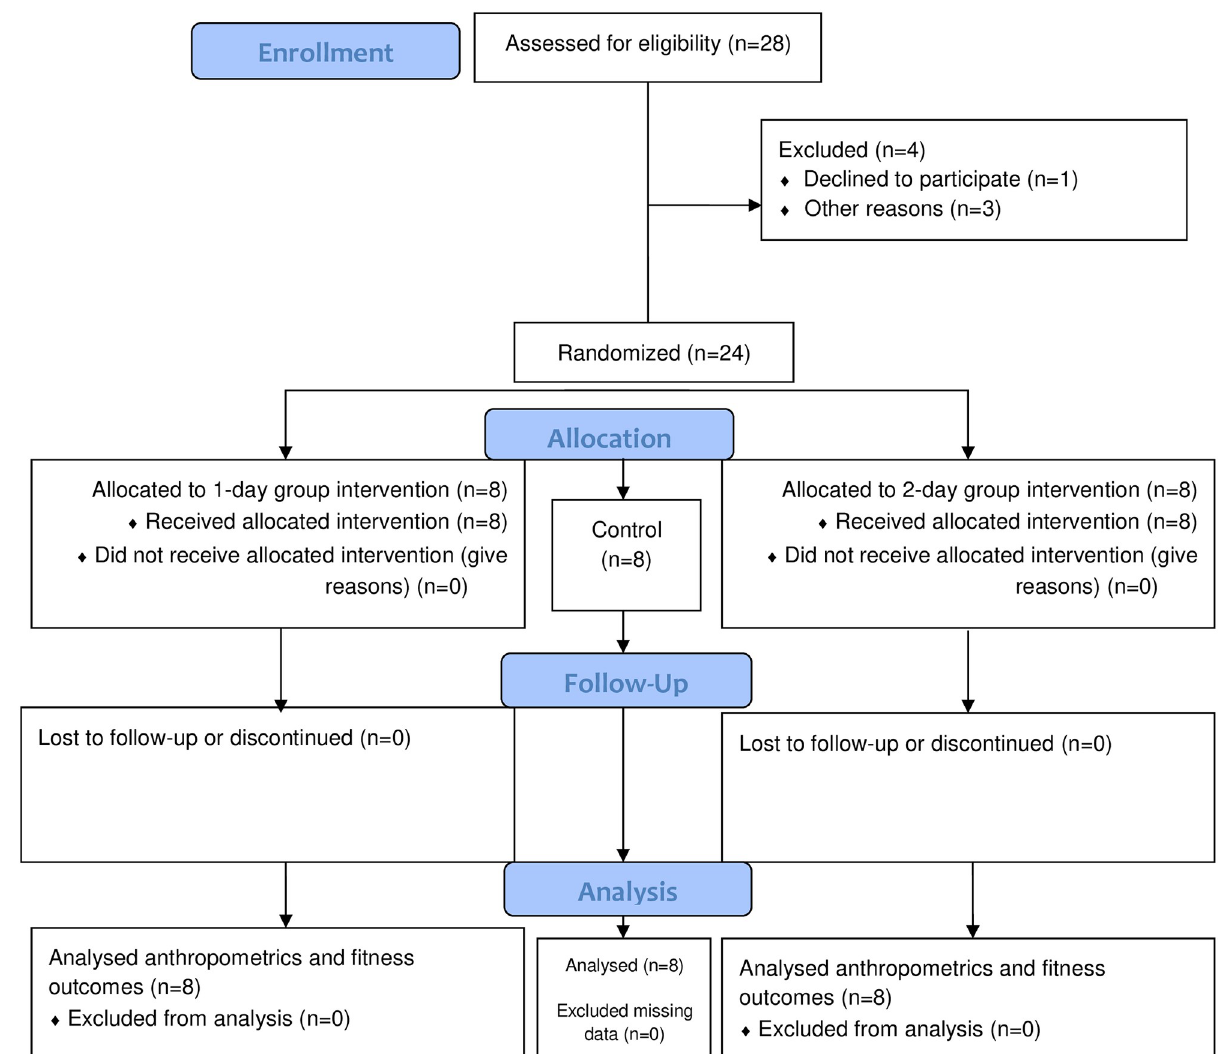
Fig 1. CONSORT (Consolidated Standards of Reporting Trials)